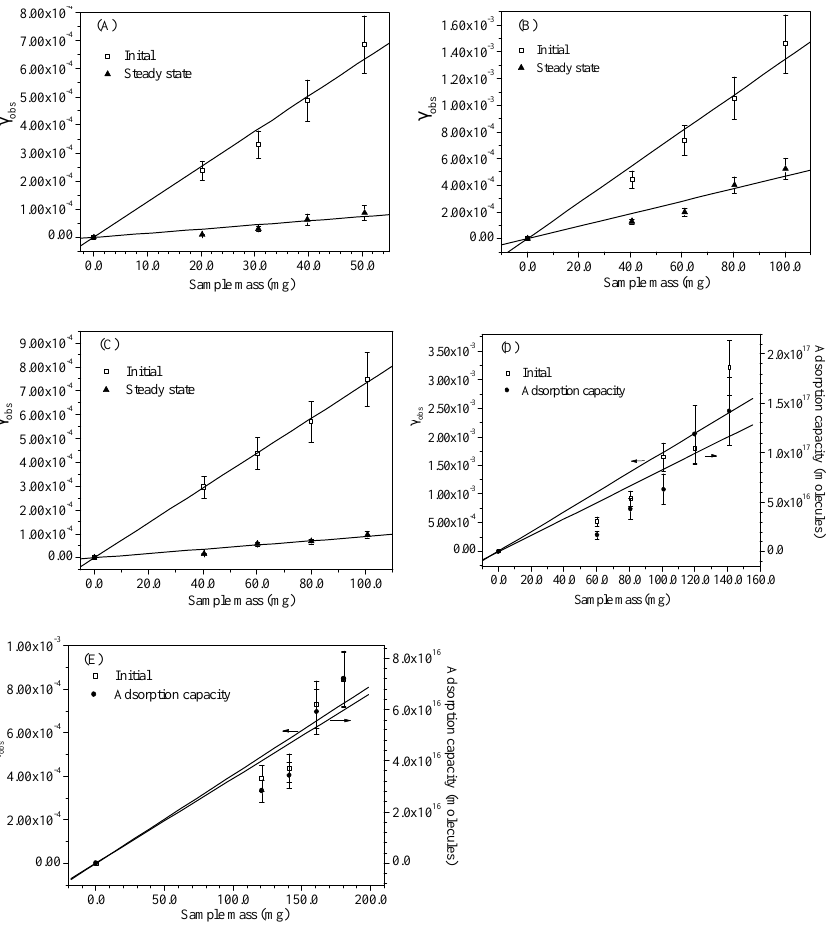
Fig. 6. The linear mass dependence between uptake coefficients or saturated adsorption capacity and sample mass for OCS on mineral oxides at 300K. (a) α -Al 2 O 3 , (b) MgO, (c) CaO, (d) α -Fe 2 O 3 , (e)